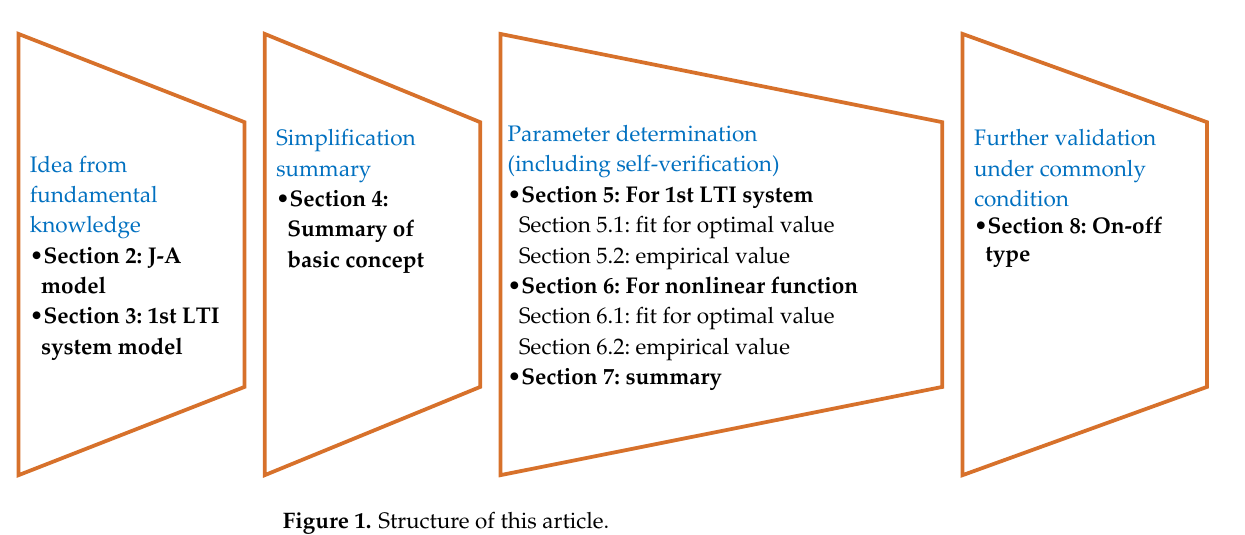
Figure 1. Structure of this article.